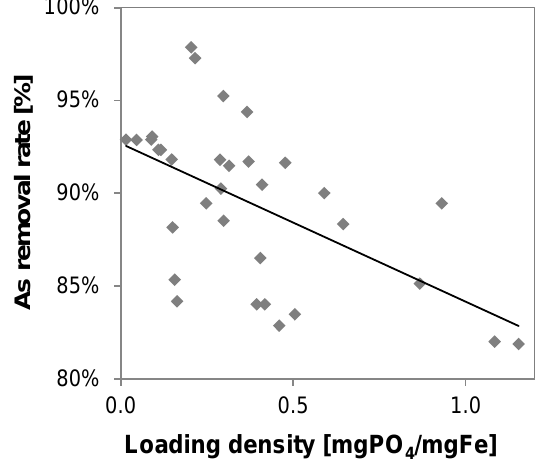
Figure 16. Arsenic removal in relation to phosphate loading density